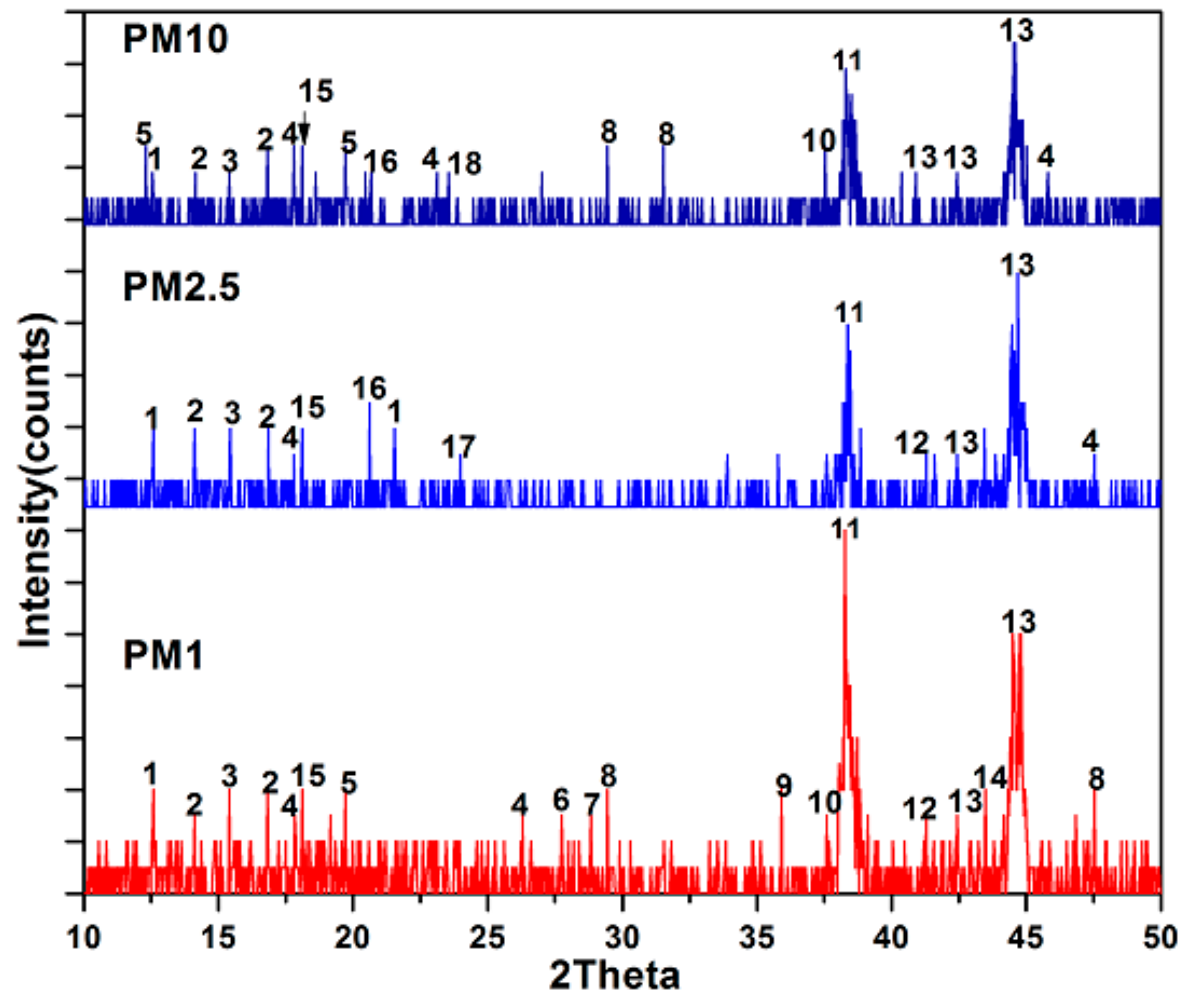
Figure 5. XRD pattern of PM 1 , PM 2.5 and PM 10 . The numbers: 1, wollastonite; 2, ammonium sulphate; 3, wustite; 4, illite; 5, kaolinite; 6, augite; 7, crocidolite; 8, calcite; 9, calcium aluminum silicate; 10, hematite; 11, copper sulphate; 12, dolomite; 13, quartz; 14, vaterite; 15, calcium iron oxide; 16, muscovite; 17, gypsum; 18, vermiculite.